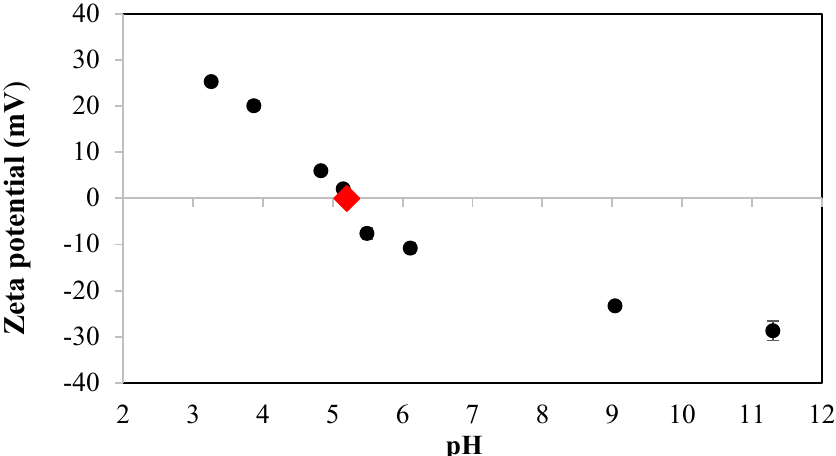
Figure 1. L-asparaginase (ASNase) zeta potential values for different pH values. • Experimental data; (cid:7) isoelectric point.